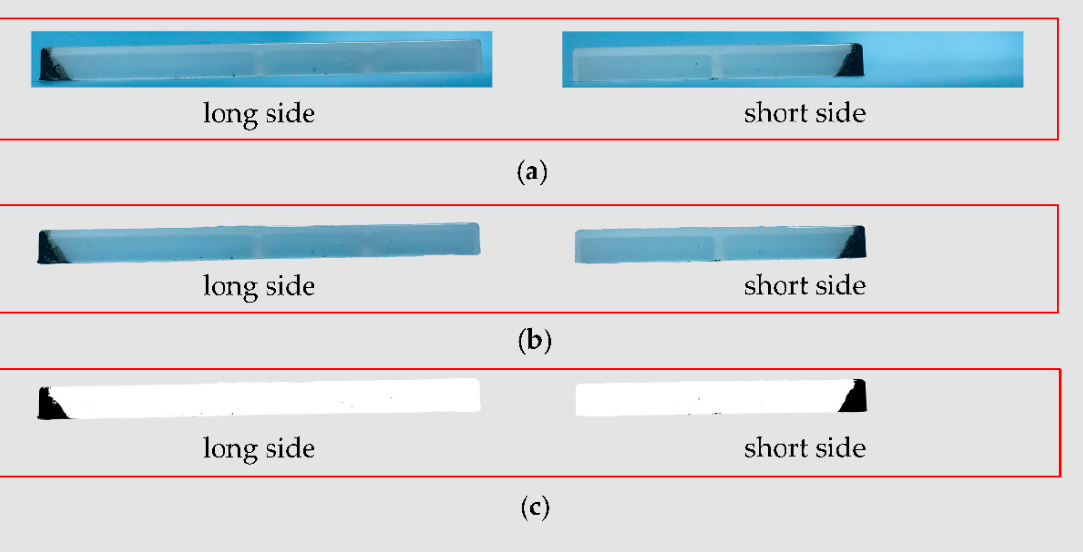
Figure 3. Images of main steps during the image processing of a part molded by CIM: ( a ) photographed images; ( b ) part images without background; ( c ) binary images.